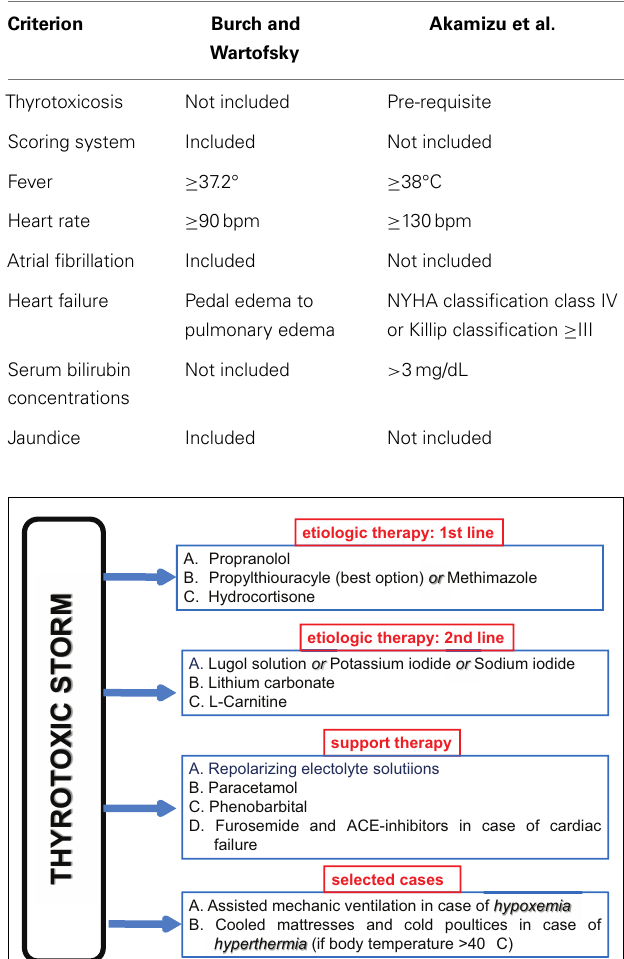
Table 4 | Differences in diagnostic criteria for thyrotoxic storm between Burch andWartofsky and the Japanese survey .